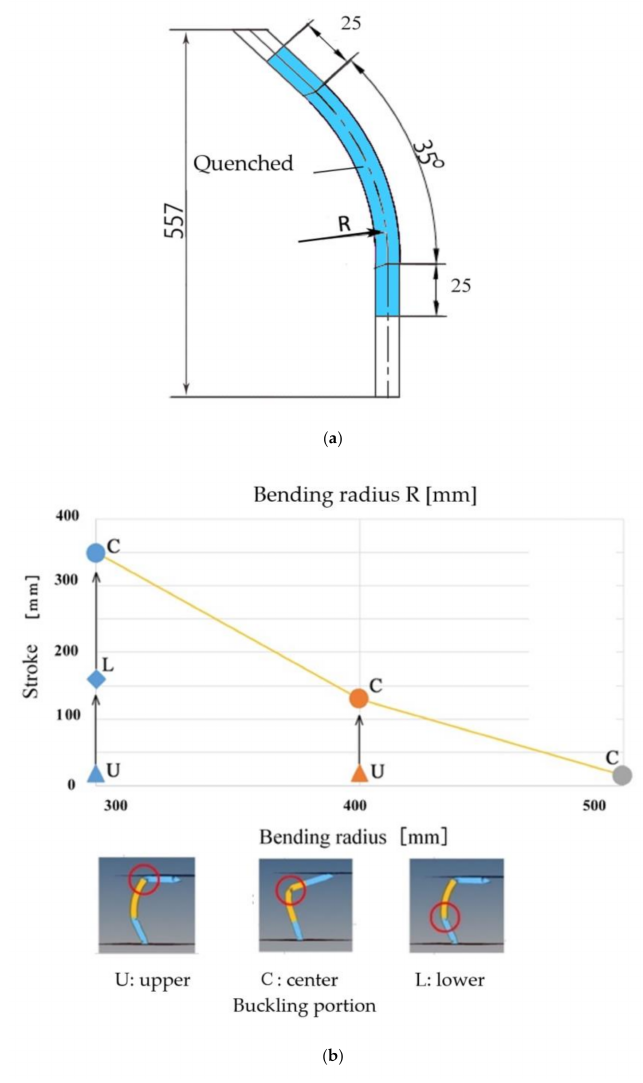
Figure 17. Relationship between bending radius and the stroke at buckling occurred for partially quenched product with extended quenched area δ = 25 mm: ( a ) initial product shape and ( b ) calculation